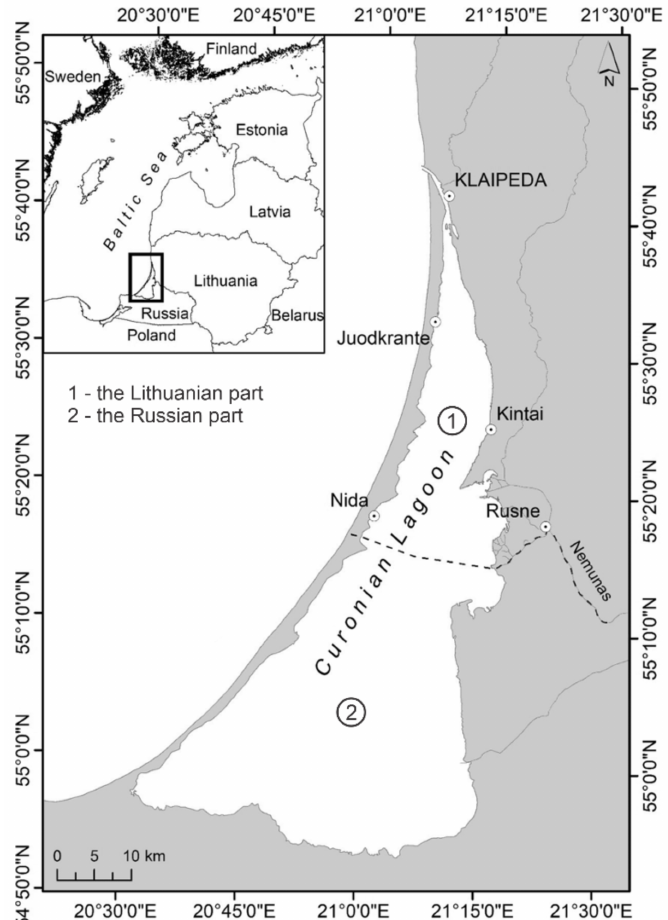
Figure 1. The study site ( 1 (cid:13) —the Lithuanian part; and 2 (cid:13) —the Russian part of the Curonian